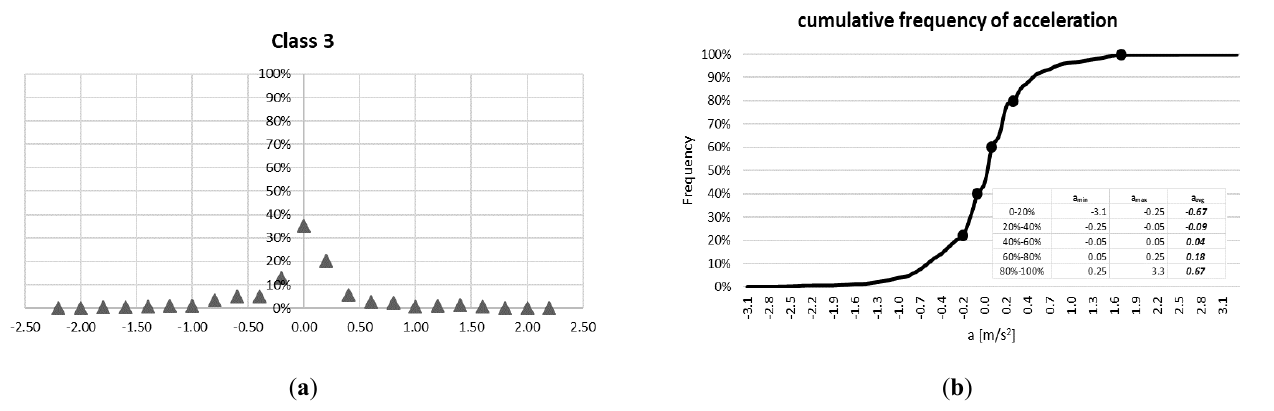
Figure 7. Updated relative ( a ) and cumulative ( b ) frequency of equipped vehicle accelerations for link class 3. Table 3. Updated parameters of vector β for each link class